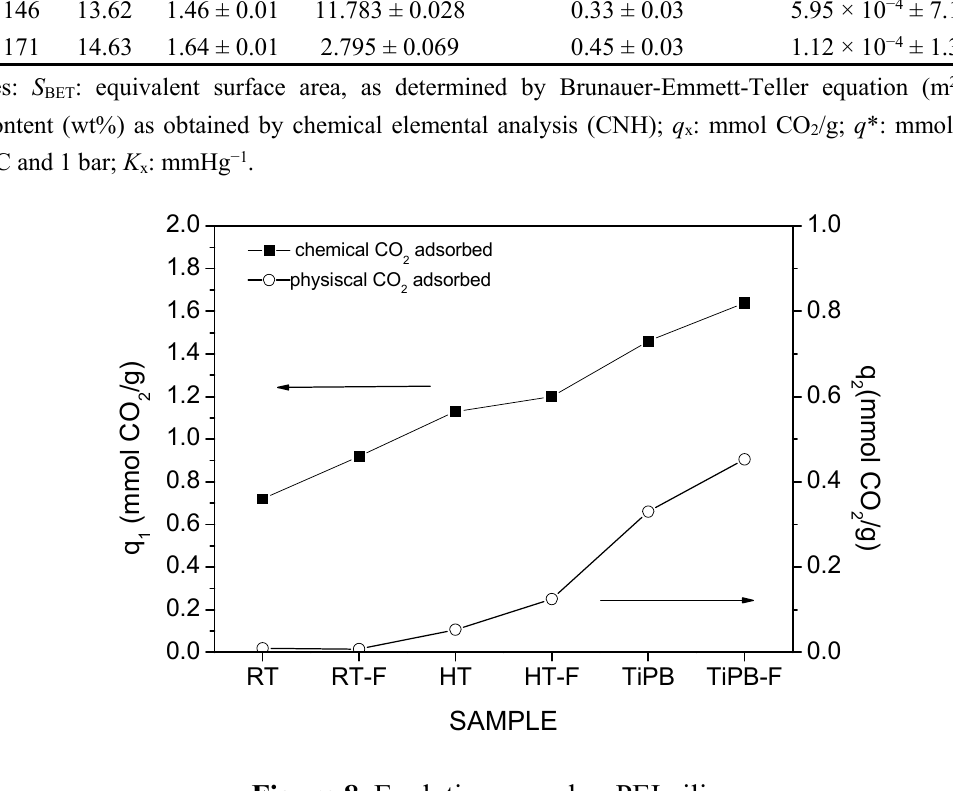
Figure 8. Evolution q 1 and q 2